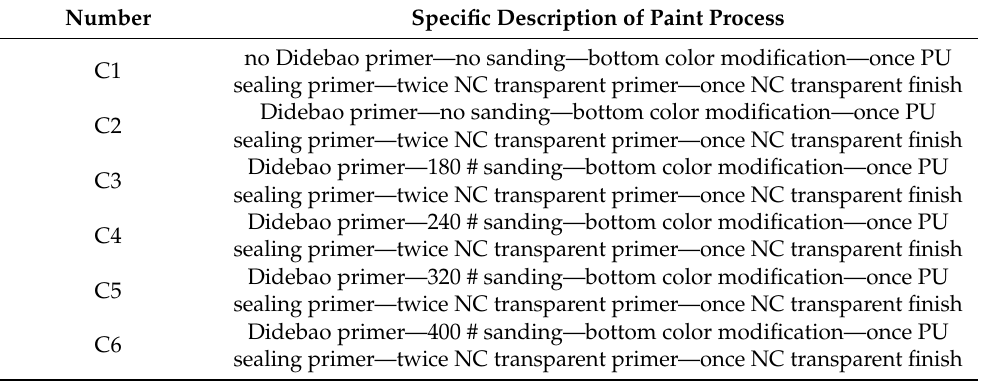
Table 3. The manufacture of specimens for Group C.